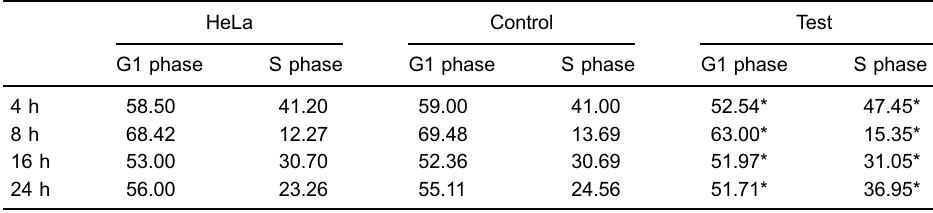
Table 2. Proportion of cells in G1 and S phases after incubation with Cu-His for different times. HeLa